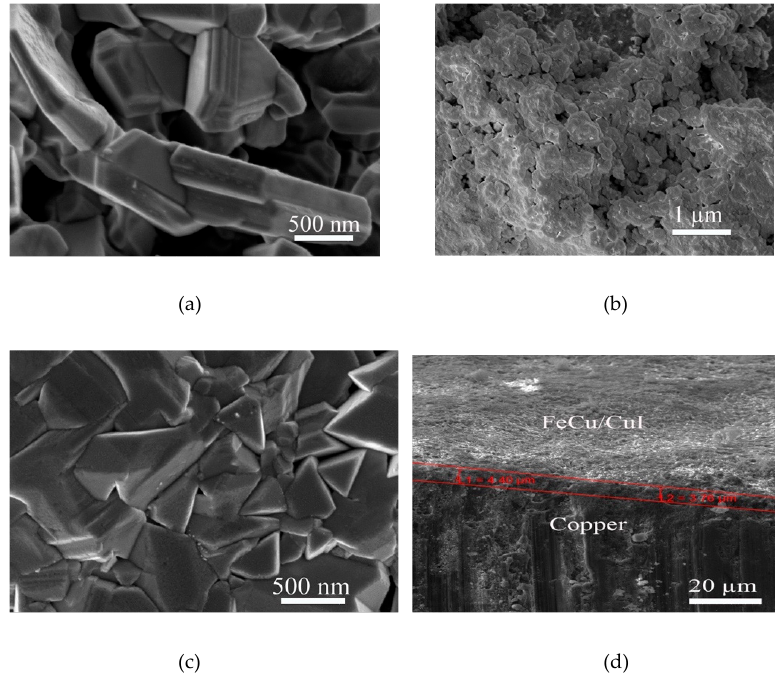
Figure 5. ( a ) Field emission scanning electron microscopy (FE-SEM) micrographs of ( a ) copper iodine growth over FeCu deposited on copper substrate, ( b ) FeCu ball-milled over CuI deposited on the cipper substrate, ( c ) CuI growth on copper substrate, showing monolithic CuI growth and ( d ) cross sectional SEM of FeCu/CuI on copper substrate.